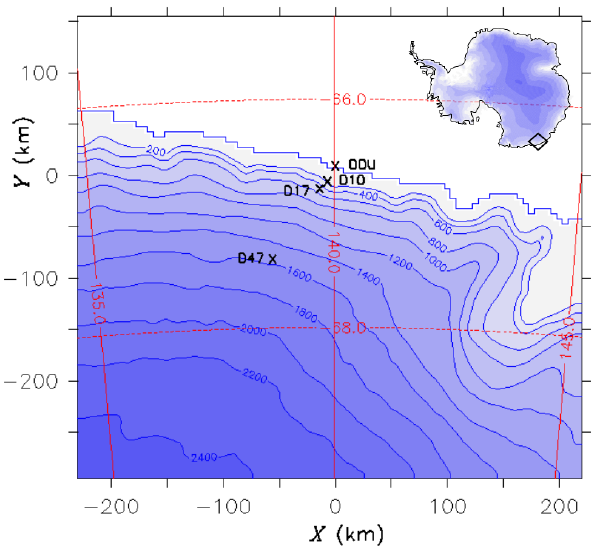
Figure 1. Topography of the area, with the location of the D17 site. Altitude lines are reported in